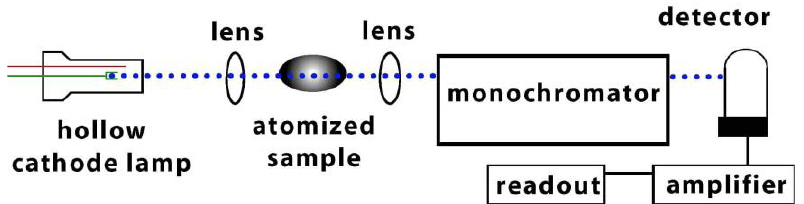
Figure 1: Schematic diagram of atomic absorption experiment (adapted)